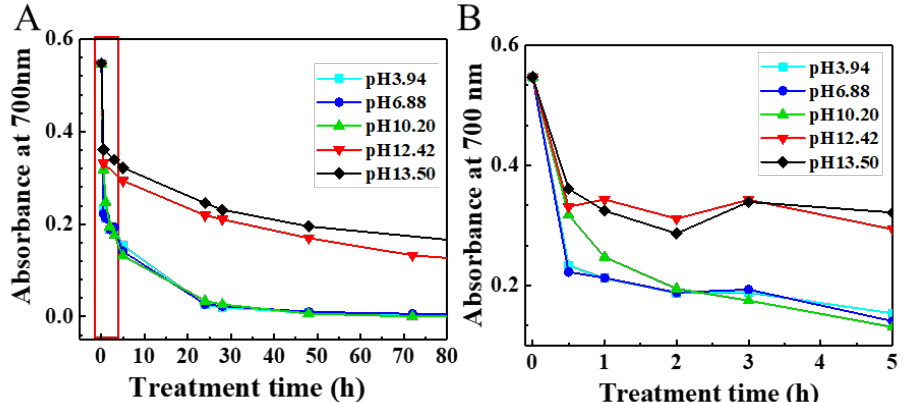
Figure 3. Degradation of SG/BSA by NaClO solution at different pH values. ( A ) Absorbance SG- CNTs at 700 nm in treatments with different pH values. ( B ) Close-up view of the red framed part in ( A ). SG/BSA is a CNT-dispersion that was obtained by dispersing SG-CNT in BSA solution (CNTs: 10 µg/mL; BSA: 0.1 mg/mL).